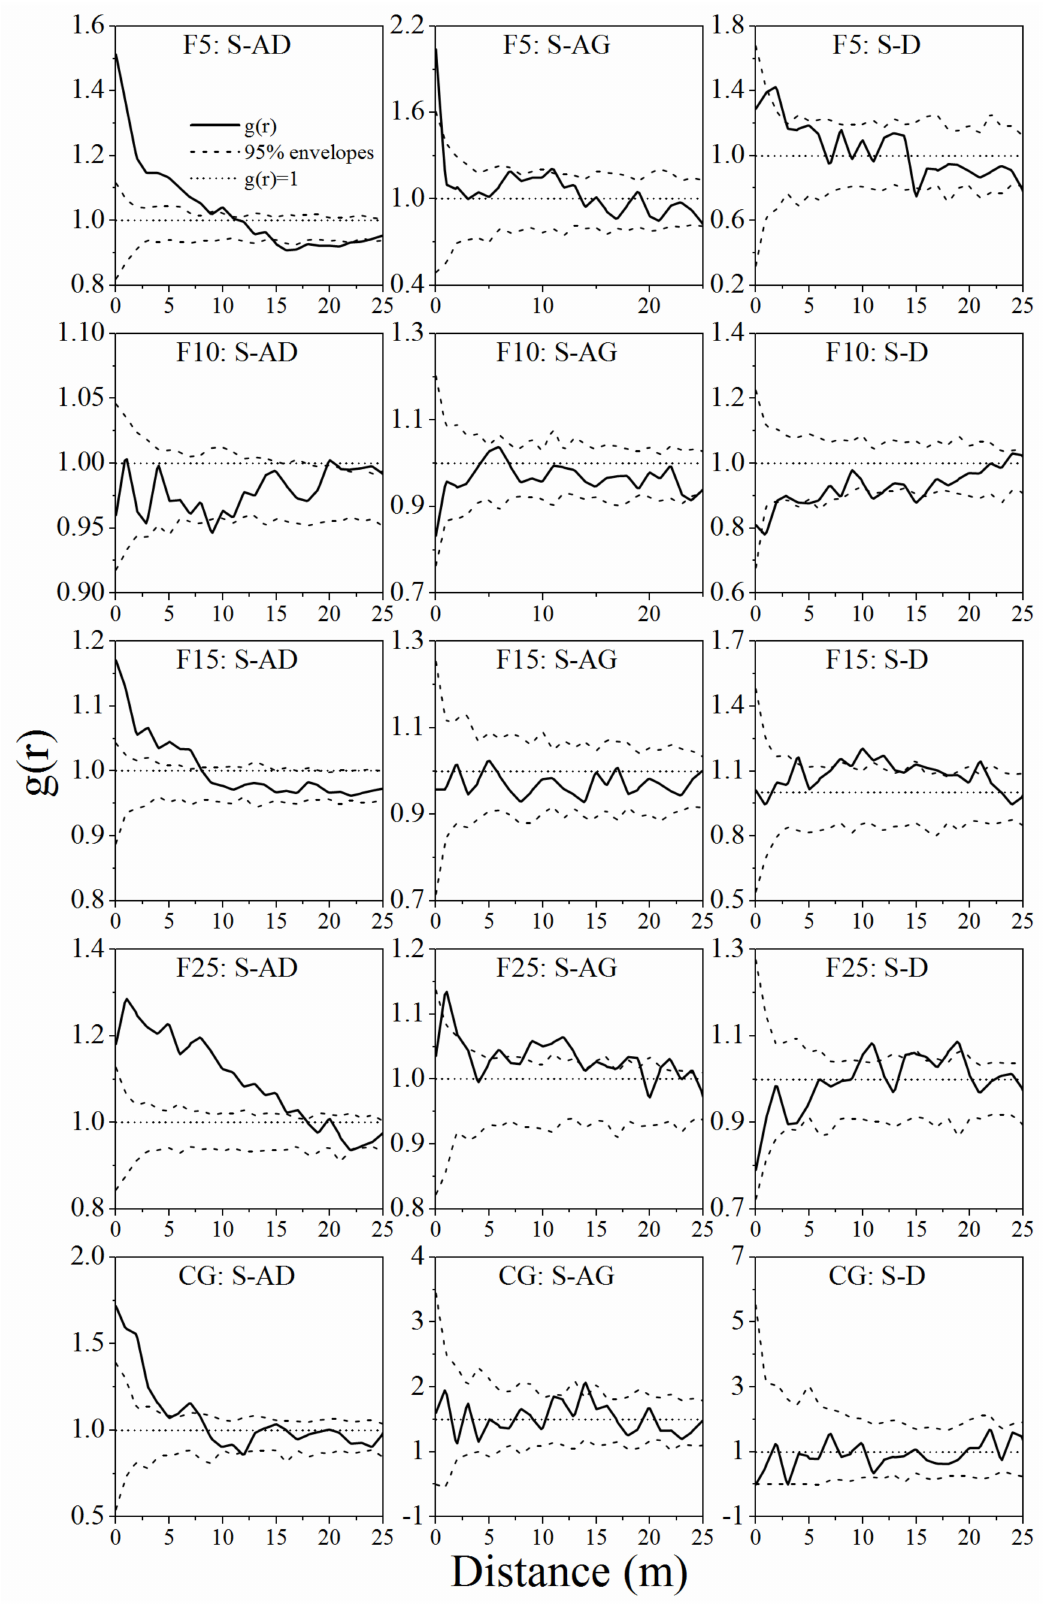
Figure 6. Intraspecific spatial correlations among different age classes of the A. ordosica population on F5, F10, F15, F25, and CG sites. S: seedling group, AD: adult group, AG: aging group, D: dead group. F5 (enclosed 5 years), F10 (enclosed 10 years), F15 (enclosed 15 years), F25 (enclosed 25 years), and CG (continuously